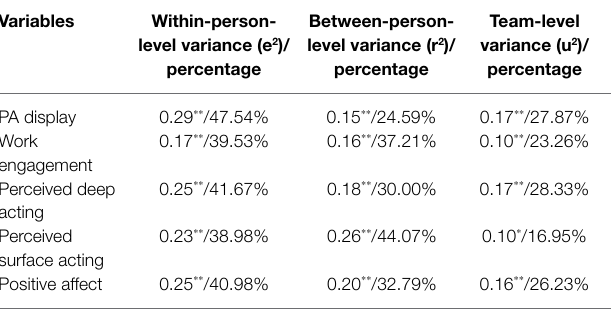
TABLE 2 | Variance components of null models for within-person-level